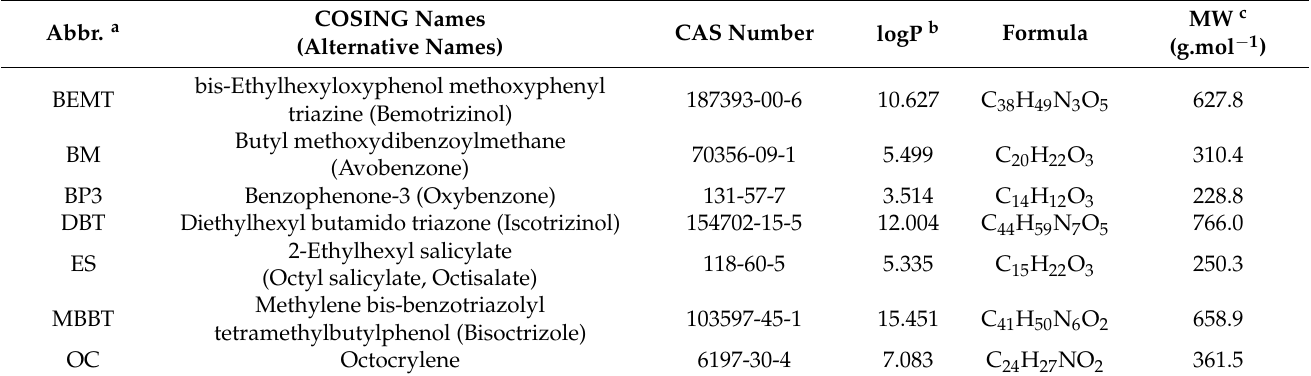
Table 1. Structures and physicochemical properties of the seven UV